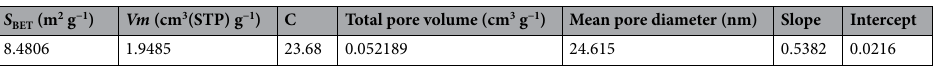
Table 1. Textural property of CuI@HNT-TSC-PC